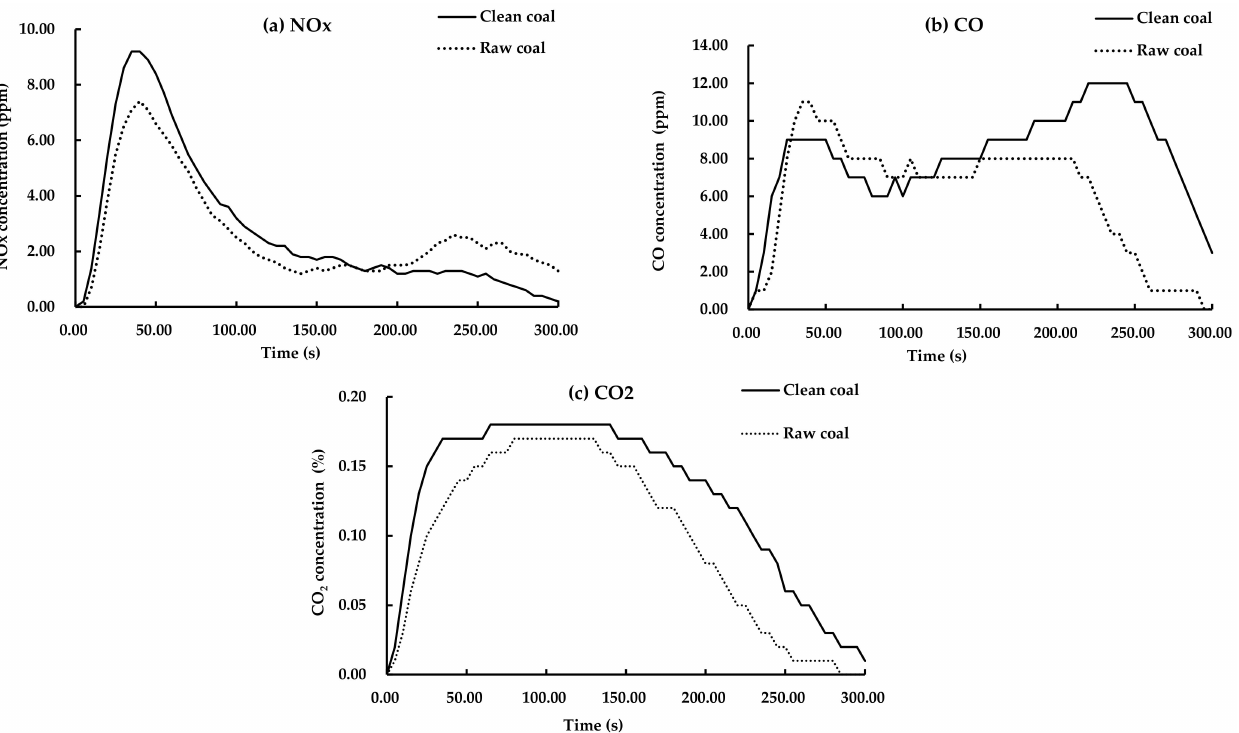
Figure 7. Analysis of the combustion exhaust. ( a ): the concentration of NOx; ( b ): the concentration of CO; ( c ): the concentration of CO 2